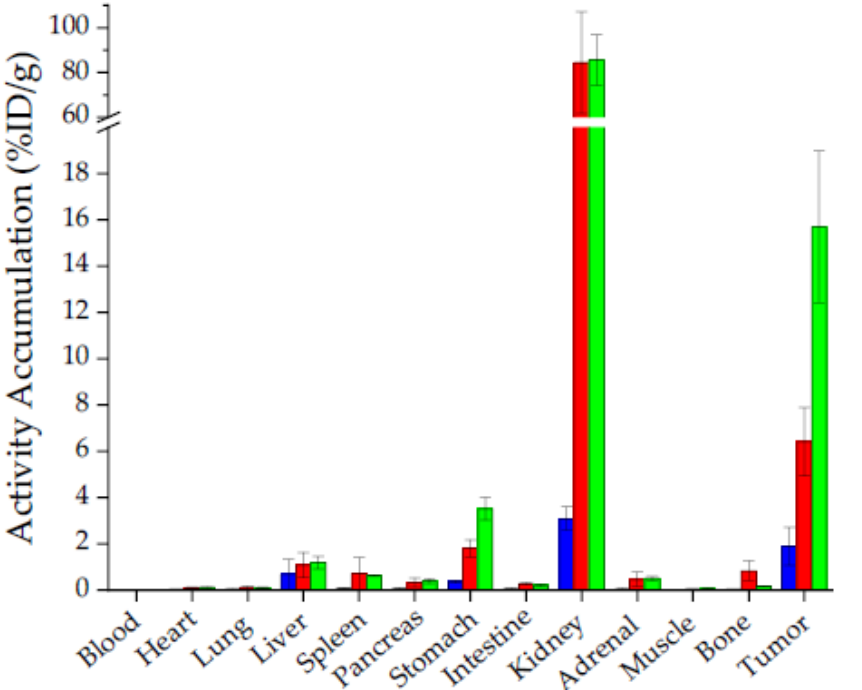
Figure 4. Biodistribution of the reference compound, [ 177 Lu]Lu-DOTA-PP-F11N (blue), the α -linked [ 177 Lu]Lu-( R )-DOTAGA-rhCCK-9 (red) and the γ -linked [ 177 Lu]Lu-( R )-DOTAGA-rhCCK-16 (green) in selected organs (%ID/g) at 24 h p.i. in AR42J tumour-bearing CB17-SCID mice (100 pmol each, n = 4). Data is expressed as mean ± SD.